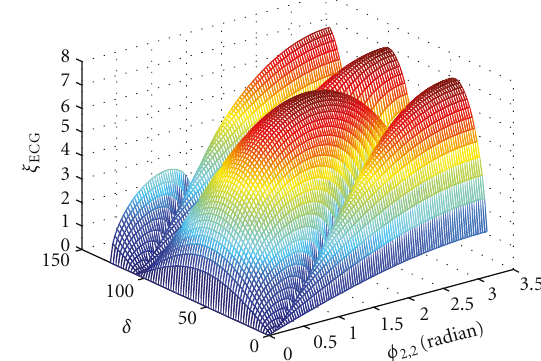
Figure 4: ˘ ξ ECG of the rate one MRP versus rotation angle φ 2,2 and δ for a MIMO-OFDM system with P = 4, N P/N t = 2 and given COST207 typical urban six-ray power delay